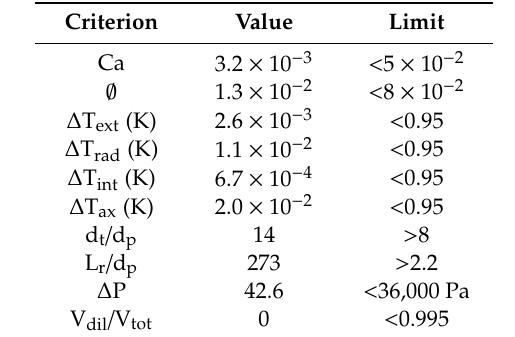
Table 1. Criteria for intrinsic kinetics of the transesterification between methanol and ethyl acetate in the (LS) 2 reactor, catalyzed by Lewatit K2629 at 60 ◦ C.